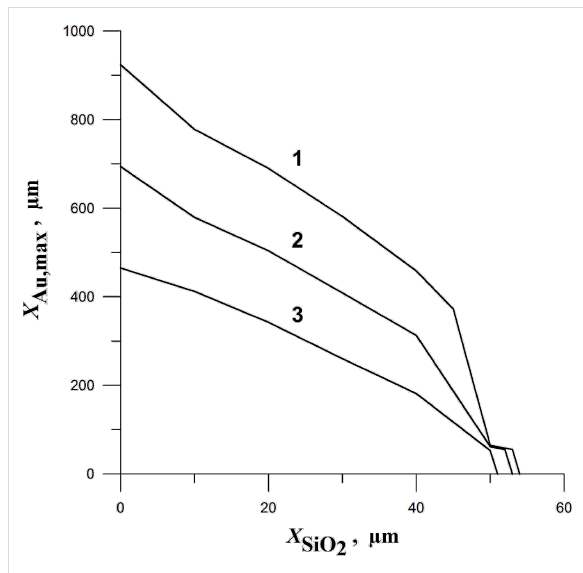
Figure 5: The maximum thickness X Au,max of the molten layer of gold versus the thickness X SiO2 of the quartz layer. Curves 1, 2, and 3 correspond to the initial bubble radii of r b0 = 0.5 cm, 0.25 cm, and 0.1 cm, respectively. The initial parameters are p 0 = 10 5 Pa and T 0 = 373 K. The pressure in the liquid far from the bubble is p ∞ = 15 p 0